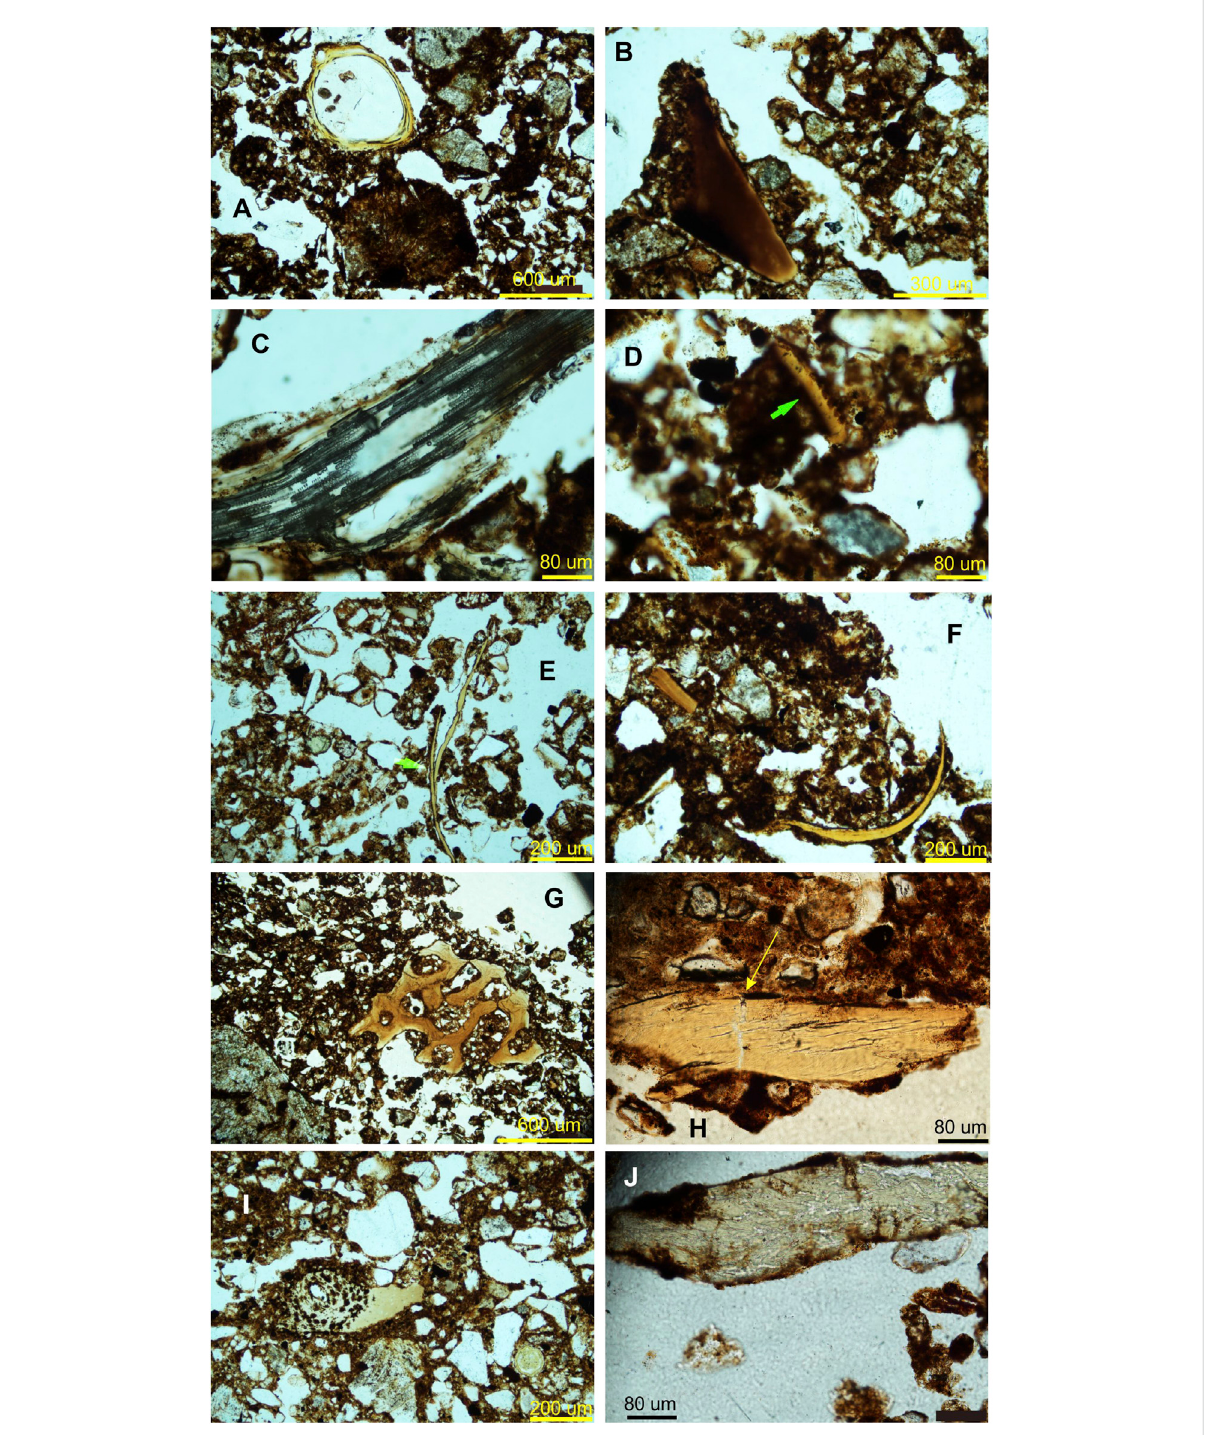
FIGURE 8 Micropictographs of bone remains in the Old Geos pro fi le, including (A) med-yellow, circular ( fi sh?) bone, (B) dark brown burnt bone, (C) degraded fi shbone, (D) burnt fi shbonewithserated-edge, (E) fi nebone,possiblyavian, (F) darkyellow, fi nebone, (G) darkyellowspongyturtlebone, (H) heated and fractured (mammal)bone, (I) cross-sectionof boneshowingmicrobialdegradation,and (J) bonefragmentalso showing evidence of microbial